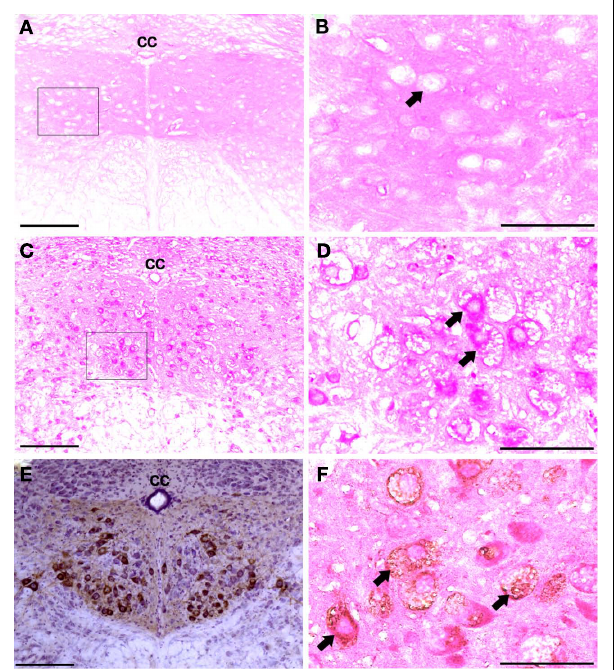
FIGURE 1 | Medullary sections showing XII motor neurons. (A–D) Show paraffin-embedded tissues cut at 10 μ m and stained with the PAS method. Positive PAS staining was not observed within neuronal cell bodies of B6/129 mice (A,B) . In contrast, XII motoneurons and cells in the surrounding areas showed robust PAS staining in Gaa − / − mice (C,D) . (B and D) Are higher magnification images of the areas indicated in (A and C) ; arrows indicate individual XII motoneurons. (E) Shows an example of CT- β labeling of the XII nuclei following tongue injection. (F) Shows a paraffin-embedded medullary section from a Gaa − / − mouse in which XII motoneurons were retrogradely labeled with CT- β .This section was also stained with the PAS method, and labeled XII motoneurons (arrows) show PAS staining consistent with what was presented in (C,D) . cc, Central canal; scale bars: ( A,C,E) : 100 μ m; (B,D,F) : 50 μ